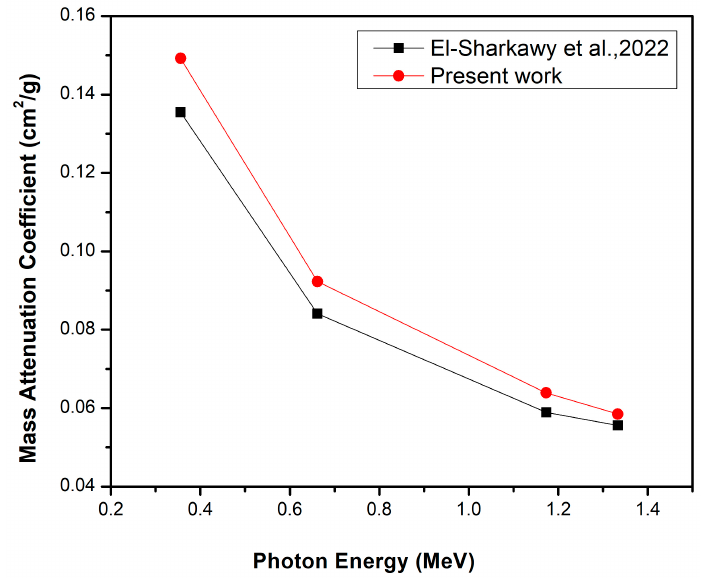
Figure 9. The comparison between the mass attenuation coefficient of 20 wt% nano-Bi 2 O 3 in benton- ite–gypsum matrix and the 20 wt% nano-Bi 2 O 3 in the bentonite matrix only (Ref. [31]).